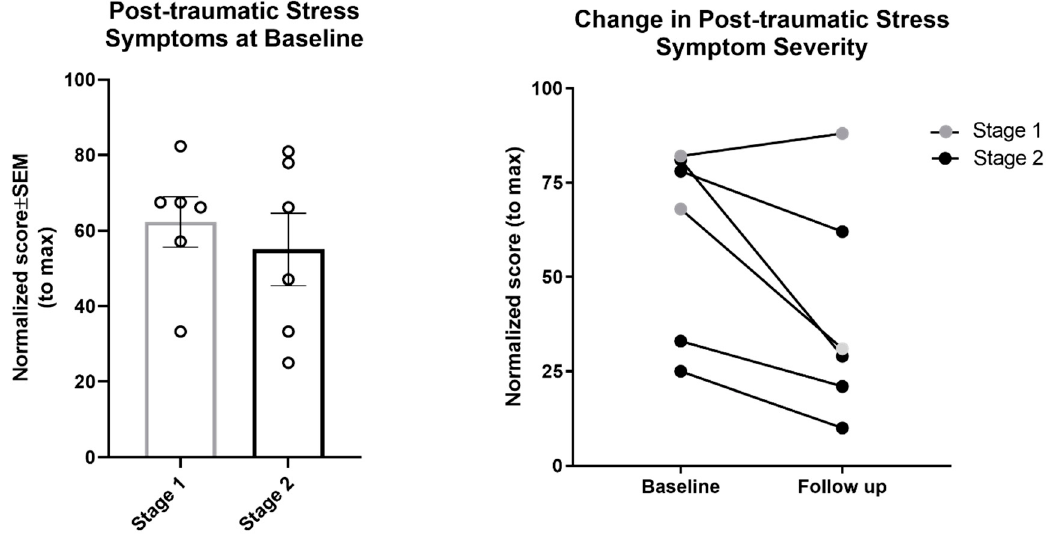
Figure 4. Post-traumatic stress symptom severity at baseline (Stage 1: n = 6; Stage 2: n = 6) and 6-month follow-up (Stage 1: n = 2; Stage 2: n = 4). Post-traumatic stress symptoms were measured on the UCLA PTSD Reaction Index or the Child and Adolescent Trauma Screen (for minors), or the PTSD Checklist for DSM-5 (for adults). Scores were normalized to the maximum score for each respective